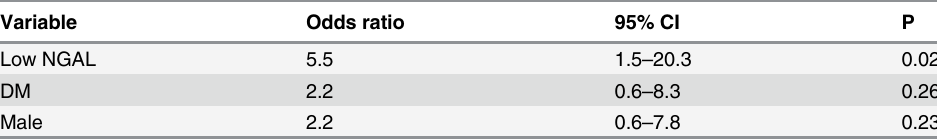
Table 6. Prediction of marked serum albumin reduction in a